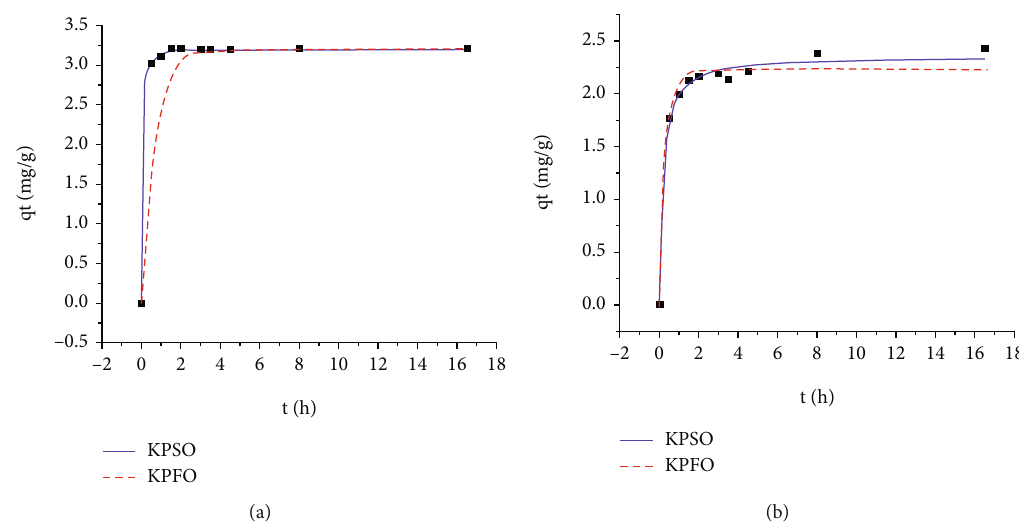
Figure 11: Adjustment of adsorption data to the kinetics models: (a) S2-NaOH and (b) S2 ( pH = 7 , 10 mg/L of Cd (II), and 150 mg of rice husk size S2: < 425-600 μ m > ).